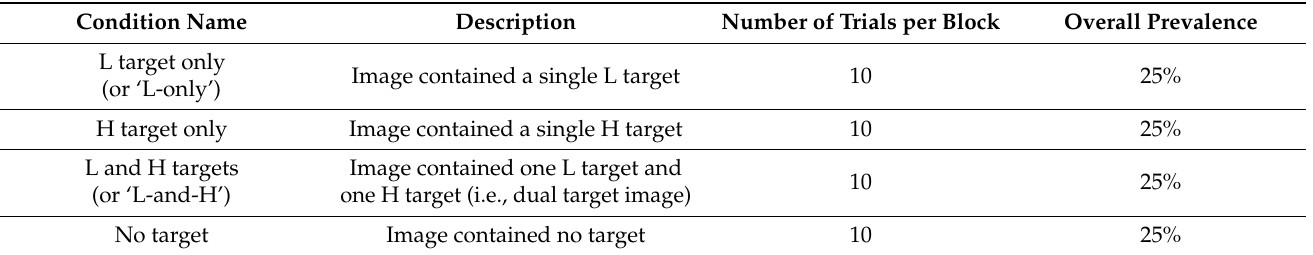
Table 2. Experimental conditions during SOS testing blocks in Experiment